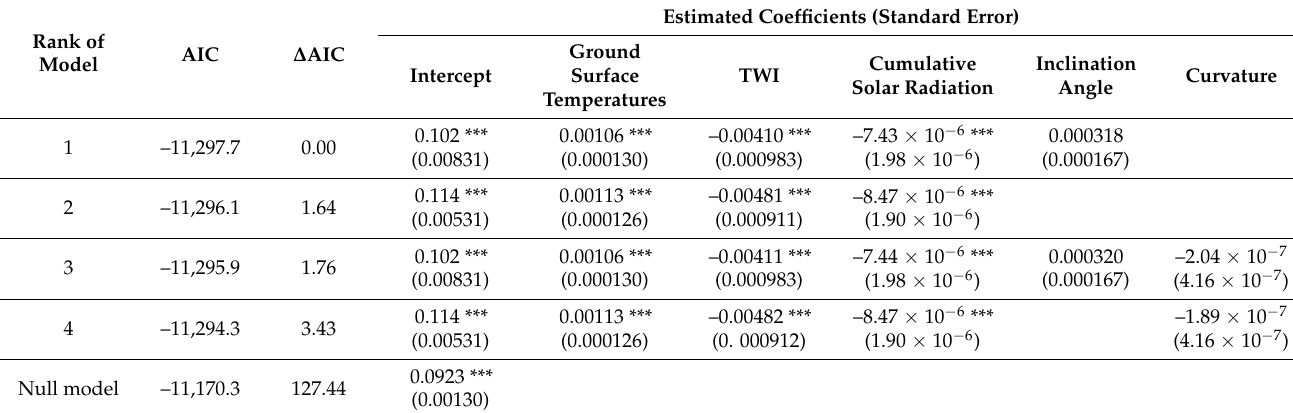
Table 3. Standardized partial regression coefficients selected in the top three models explaining the freeze-thaw amount. Rank of